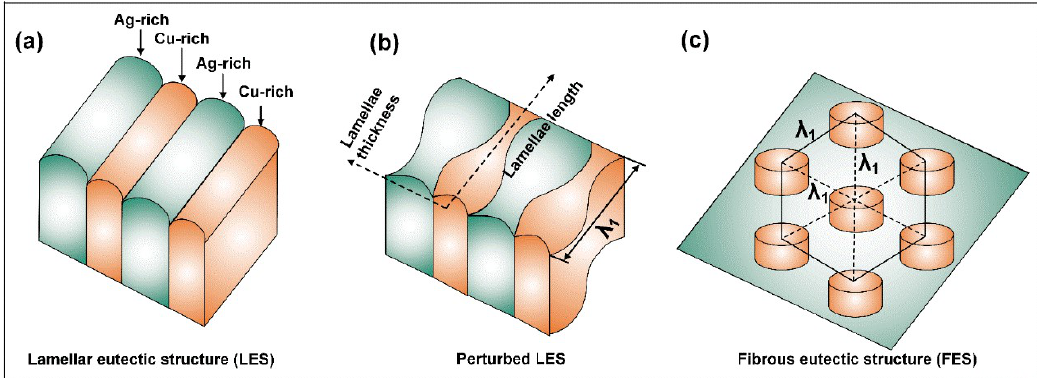
Figure 8. Schematic diagrams of LES ( a ), perturbed LES ( b ) and FES ( c ).